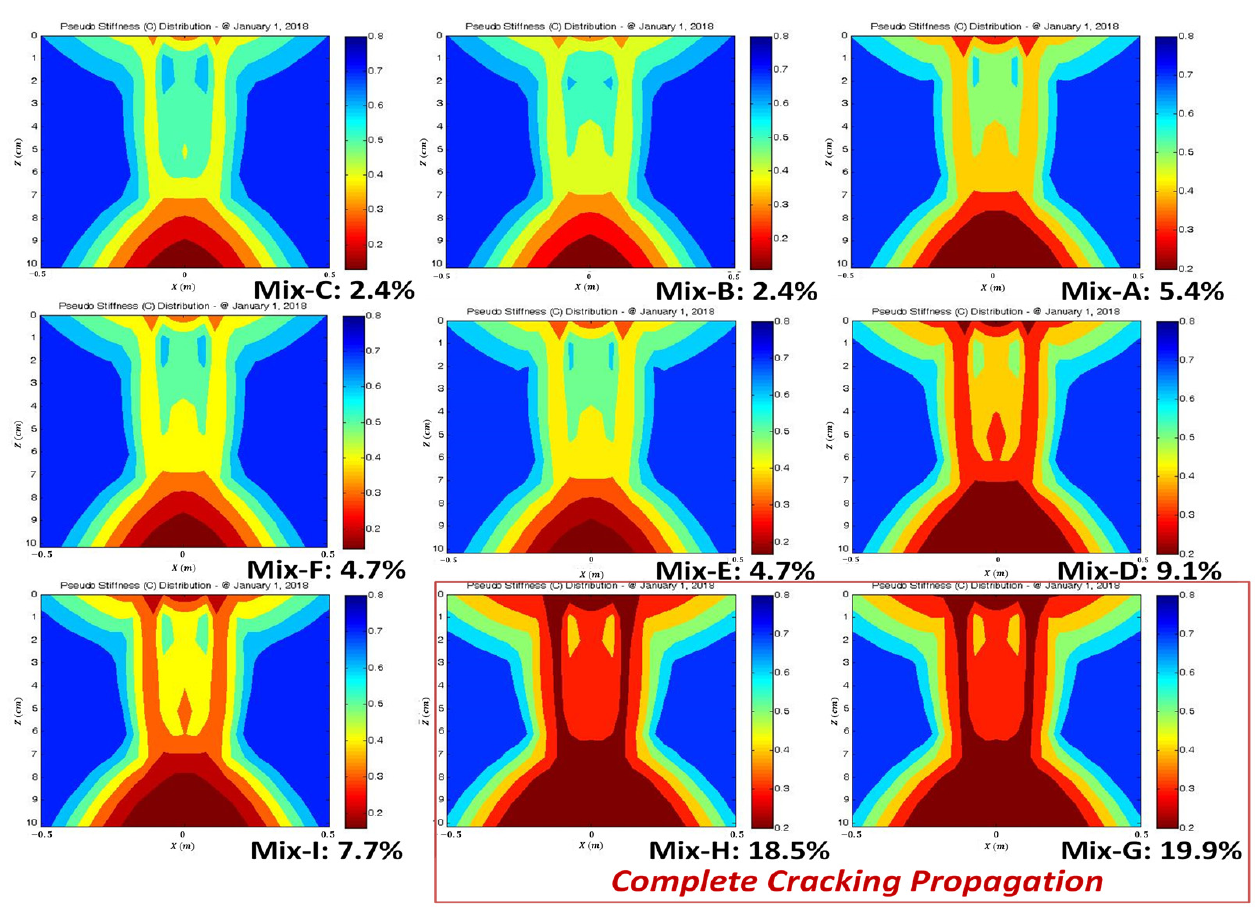
Figure 9. LVECD fatigue performance results: fatigue damaged area (%) results of nine mix designs at 101.6 mm (4 in) of thick pavement.